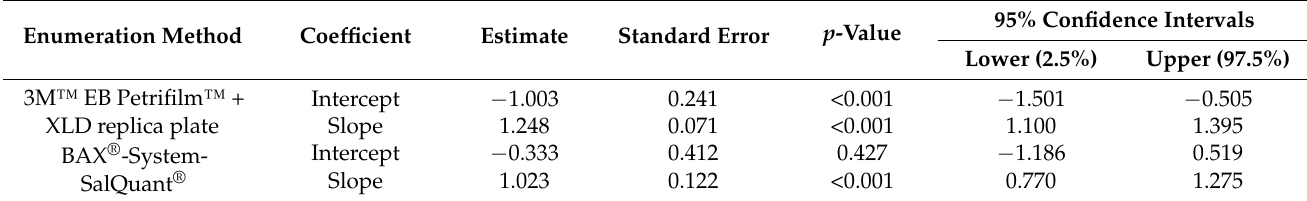
Table 1. Summary table of linear models using the least squares regression method predicting the bacterial counts of 3M™ EB Petrifilm™ + XLD replica plate and BAX ® -System-SalQuant ® when compared with MPN for quantification of Salmonella in pork lymph nodes (n = 25 per